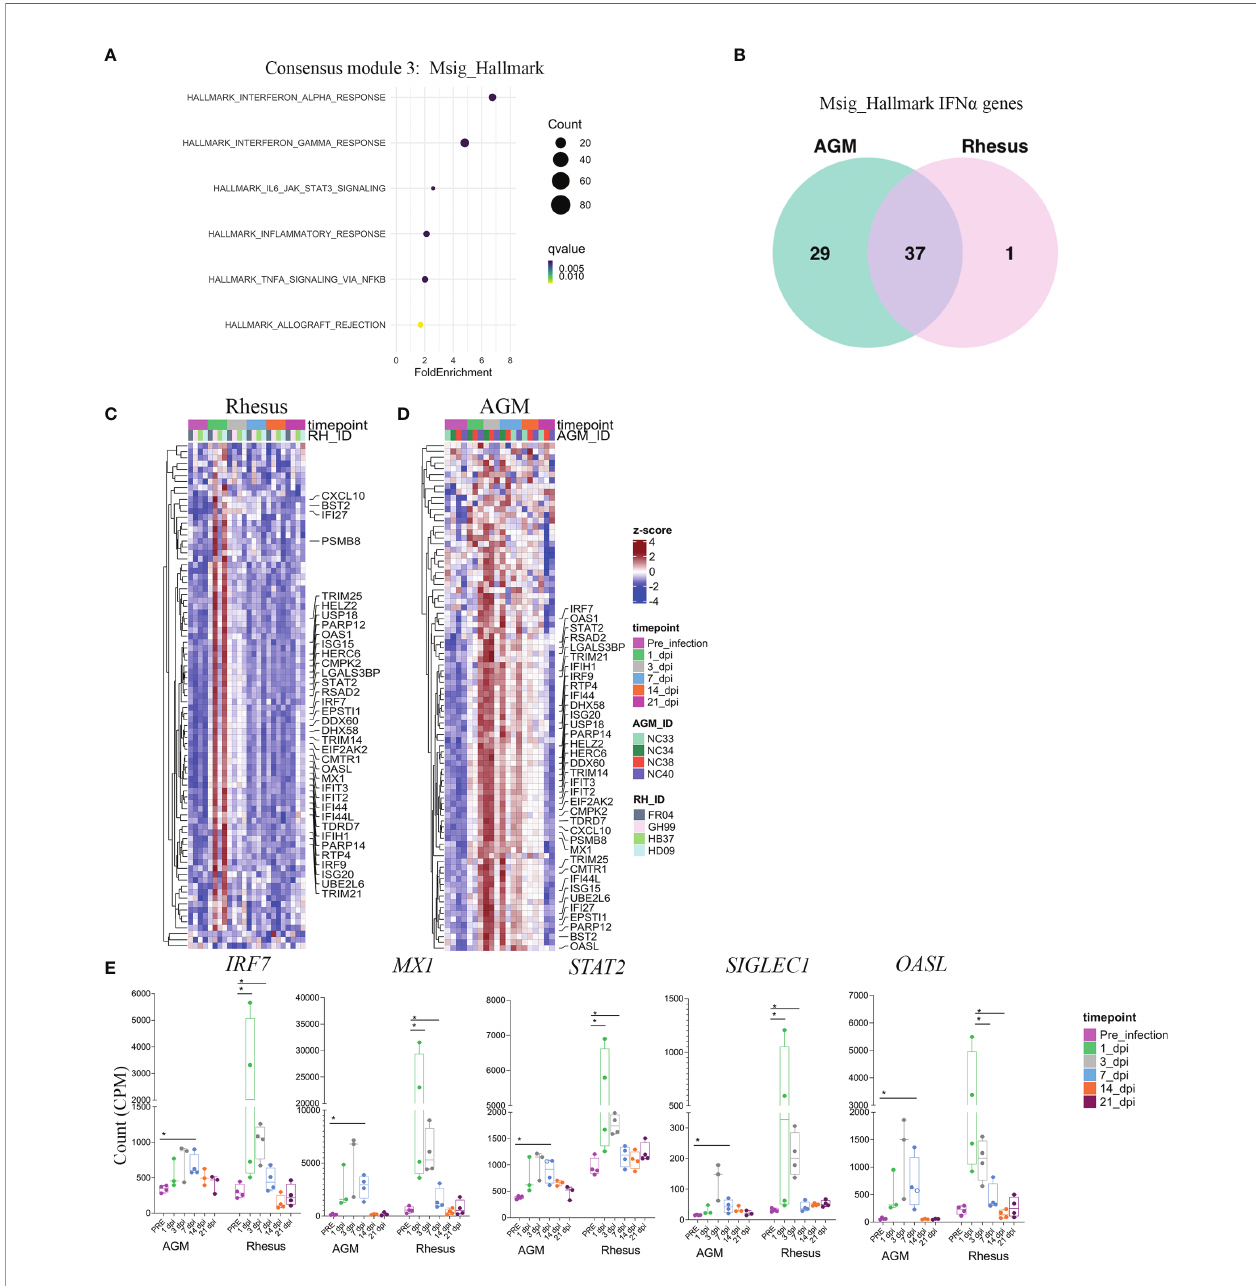
FIGURE 3 | Early type I interferon responses are a shared feature of the SARS-CoV-2 host response in RMS and AGMs. (A) Pathway analysis of genes comprised in module 3, according to the Msig_Hallmark pathway database. Fold enrichment represents the ratio of the fraction of consensus module 3 genes Falling with the biological pathway over the fraction of biological pathway genes within the entire gene universe. (B) Venn diagram of type I interferon genes comprising consensus module 3 that are shared between species and those that are unique. Heatmaps comprising all genes in the HALLMARK INTERFERON ALPHA pathway are shown in RM (C) and AGM (D) . Annotated genes represent those within HALLMARK INTERFERON ALPHA present in consensus module 3 that are shared bewteen species. (E) Selected genes in the type I IFN response with relavance to SARS-CoV-2 pathogenesis. Signi fi cance was assessed by a multiple comparison corrected Fisher ’ s Exact test in (A) , and a non-parametric Mann-Whitney U test in (E) . *p <